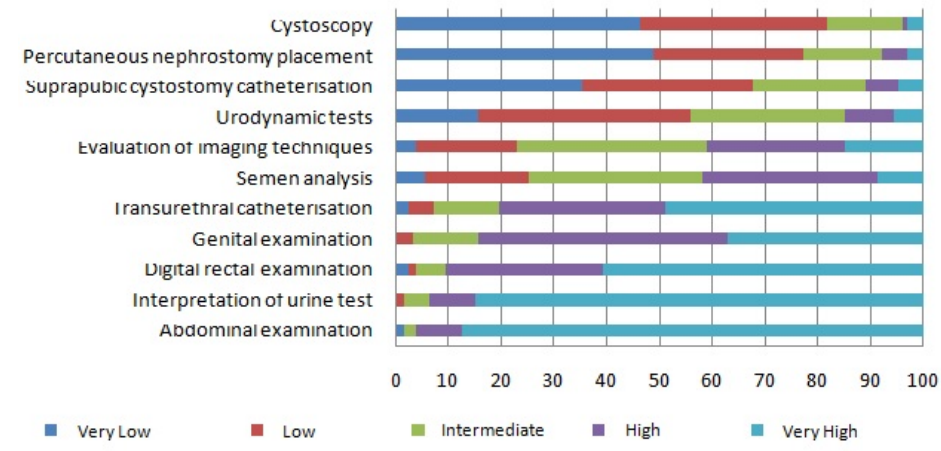
Figure 2. Evaluation of urological competences: objective questions.